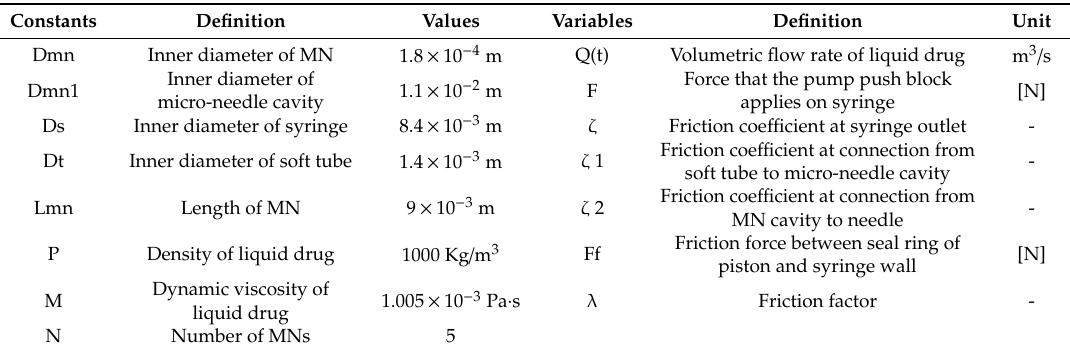
Table 2. Constants and variables used in Equation (24) [129].